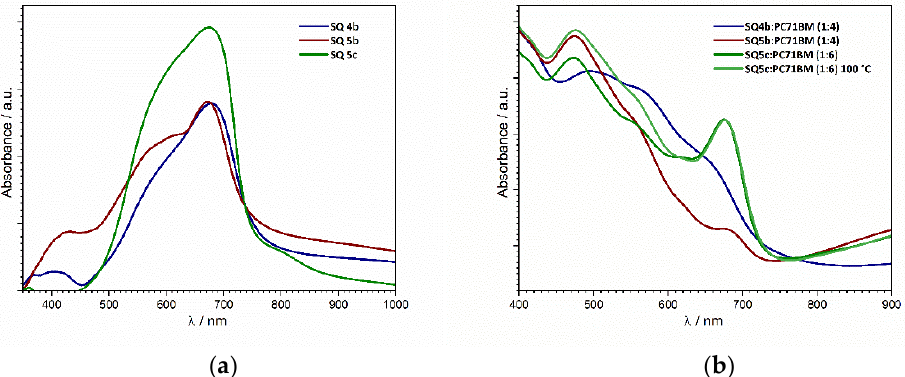
Figure 9. ( a ) Normalized UV-VIS spectra of pristine squaraine drop-cast thin films. The optical bandgap was determined from the onset values (SQ 4a could not be drop-cast); ( b ) UV-VIS spectra of BHJ thin films in different ratios and post-processing treatments spin-coated from solutions in chloroform. Table 3. Estimated values of HOMO/LUMO levels and optical bandgaps for each compound. Compound